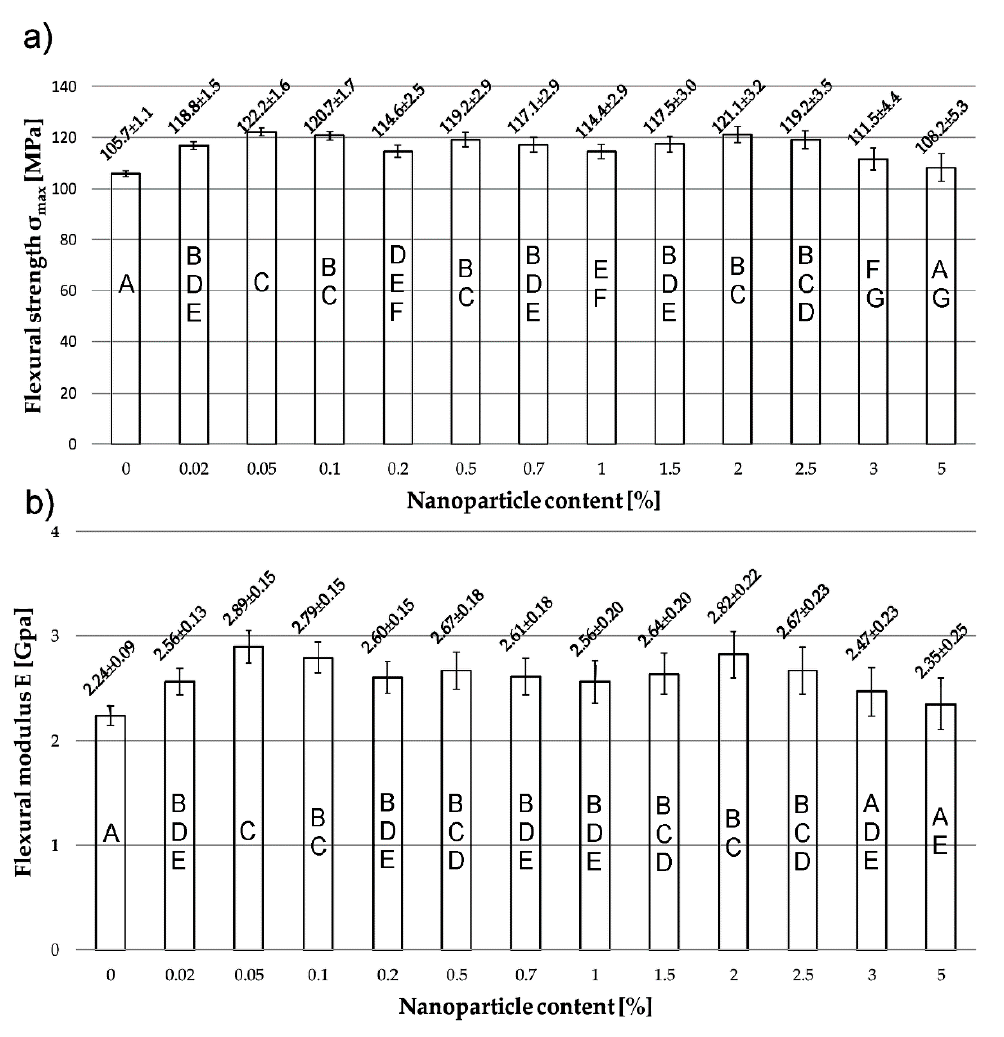
Figure 2. The nanoparticle content influence on flexural strength ( a ) and flexural modulus ( b ) of the unmodified and modified PMMA specimens. Letters indicate the statistical difference between specimens, whereby common letters indicate statistically insignificant differences.